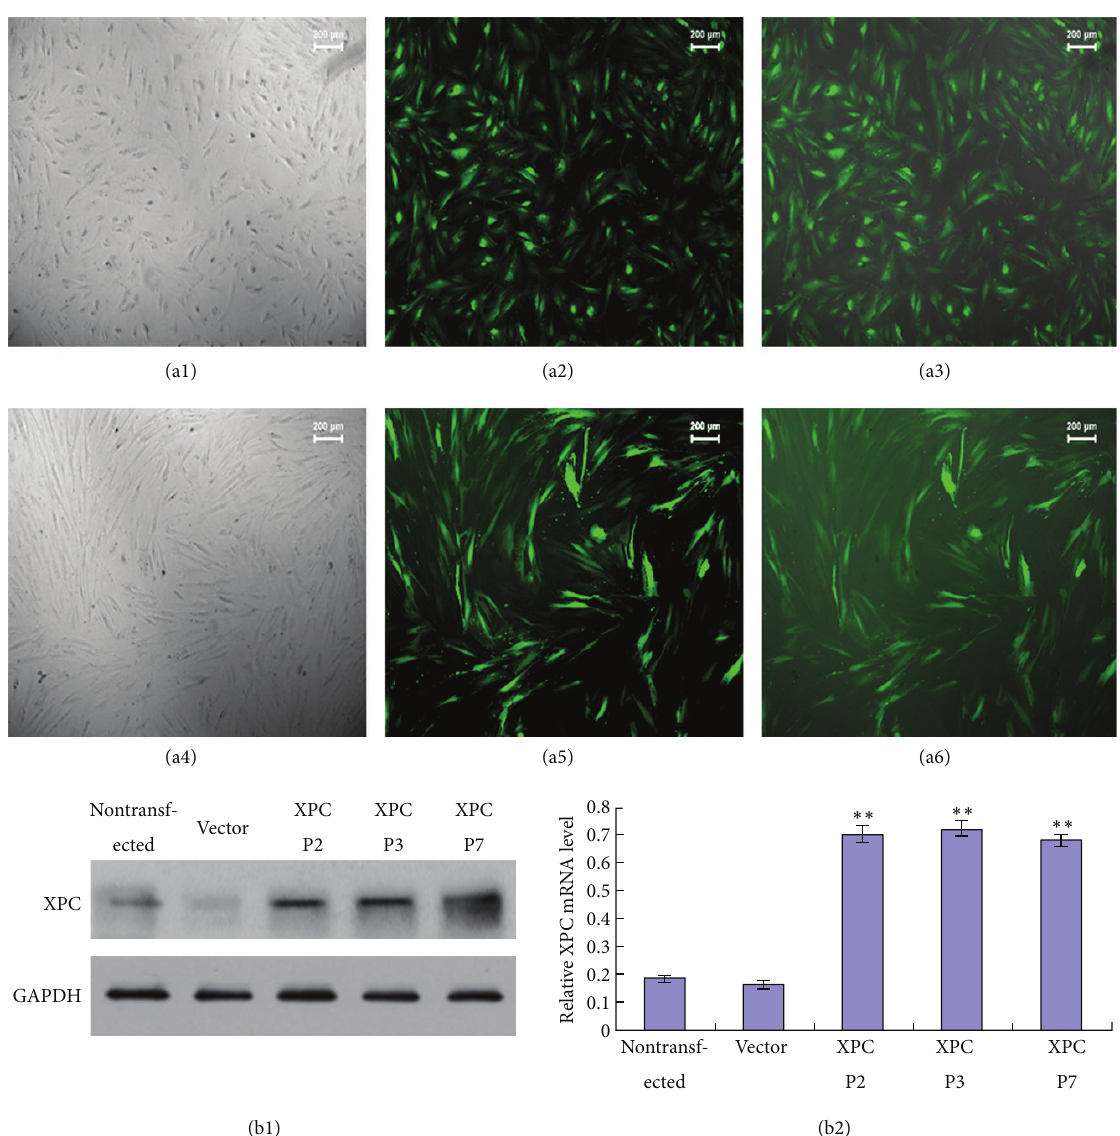
Figure 2: Establishment of XPC overexpression DPCs model. Expression of pCDH-CMV-XPC-EF1-copGFP plasmid in HEK293T cells and DPCs at P2 (a1–a6). Strong green fluorescence was detected in HEK293T cells (a2, × 50) and DPCs (a5, × 100) after transfection. Combined figures of the bright field and fluorescence figure (a3, a6). Western blot and real-time PCR showed that the expression of XPC was enhanced in XPC+/DPCs at P2 at both protein and mRNA level compared with vector group, and XPC maintained high expression level in DPCs at P3 and P7 ( ∗∗ 𝑝 < 0.01 ) (b1,